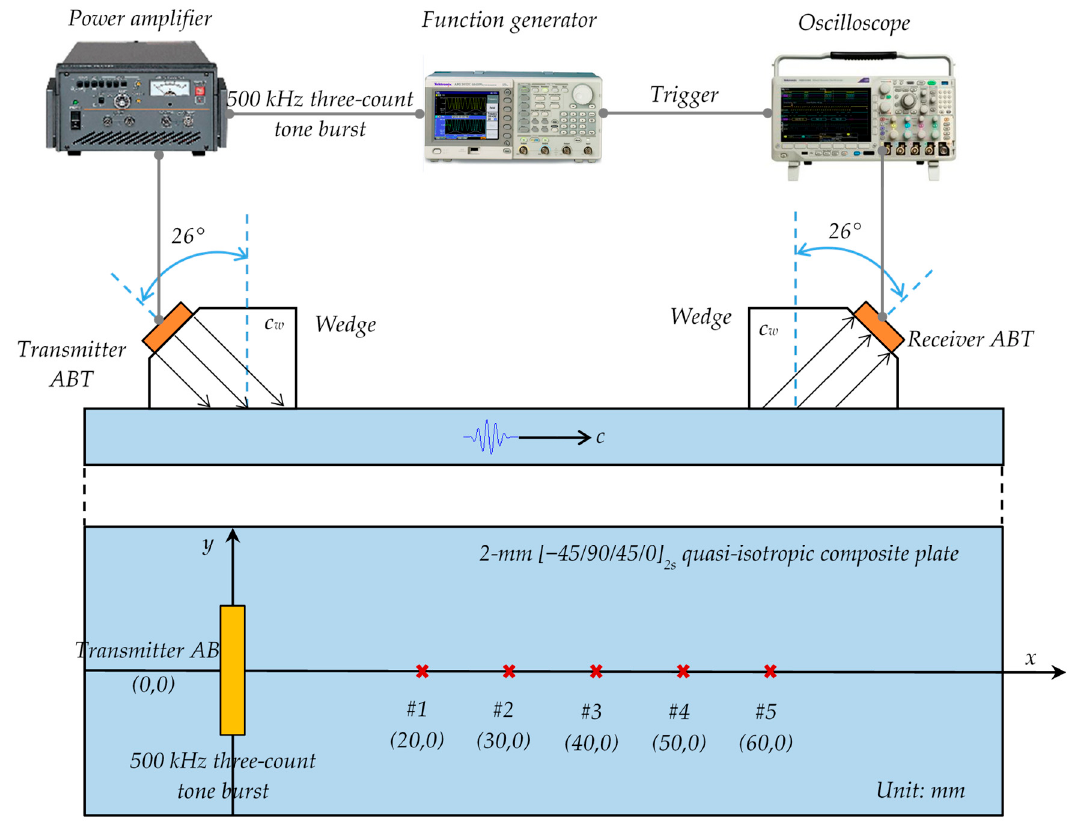
Figure 9. Experimental setup for the excitation and detection of pure S0 mode on a 2-mm [ − 45/90/45/0] 2s quasi-isotropic composite plate using ABT–ABT.